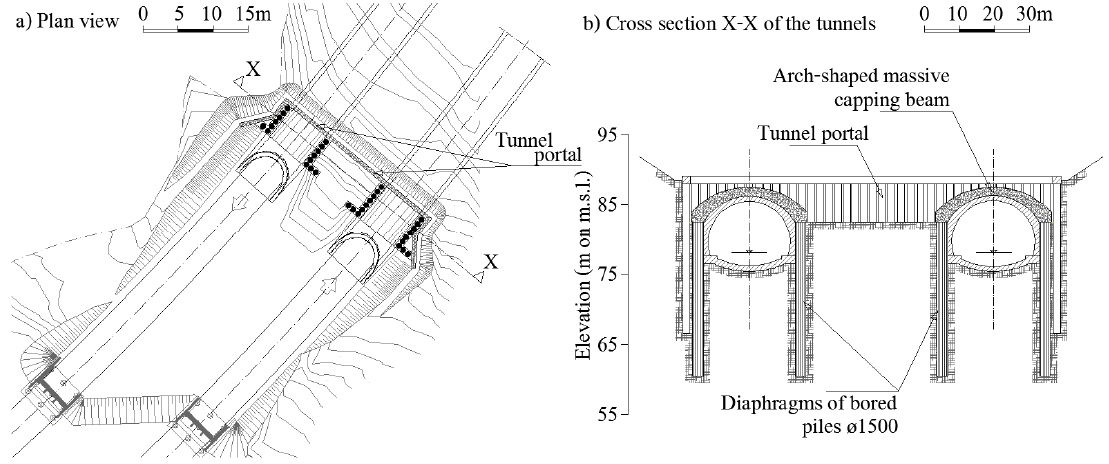
Figure 10. ( a ) Plan view of the Timpa southern entrance; ( b ) cross-section X-X of the tunnels.